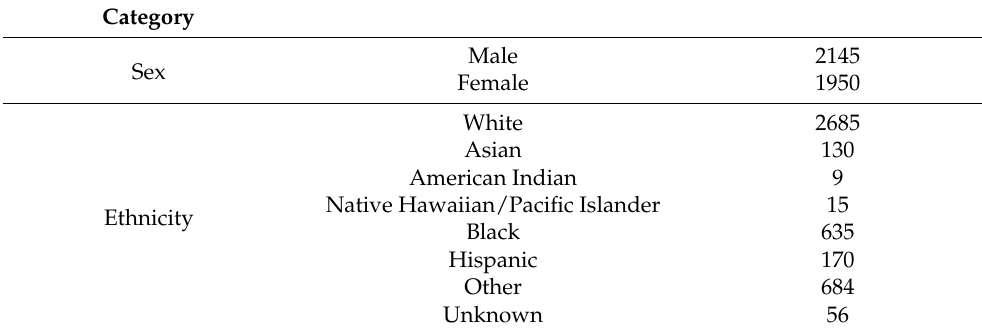
Table 2. Demographics for Down syndrome patient cohort. Gender and ethnicity values are Epic- coded. Ethnicity values are not mutually exclusive, and each row combined does not add up to the total number of